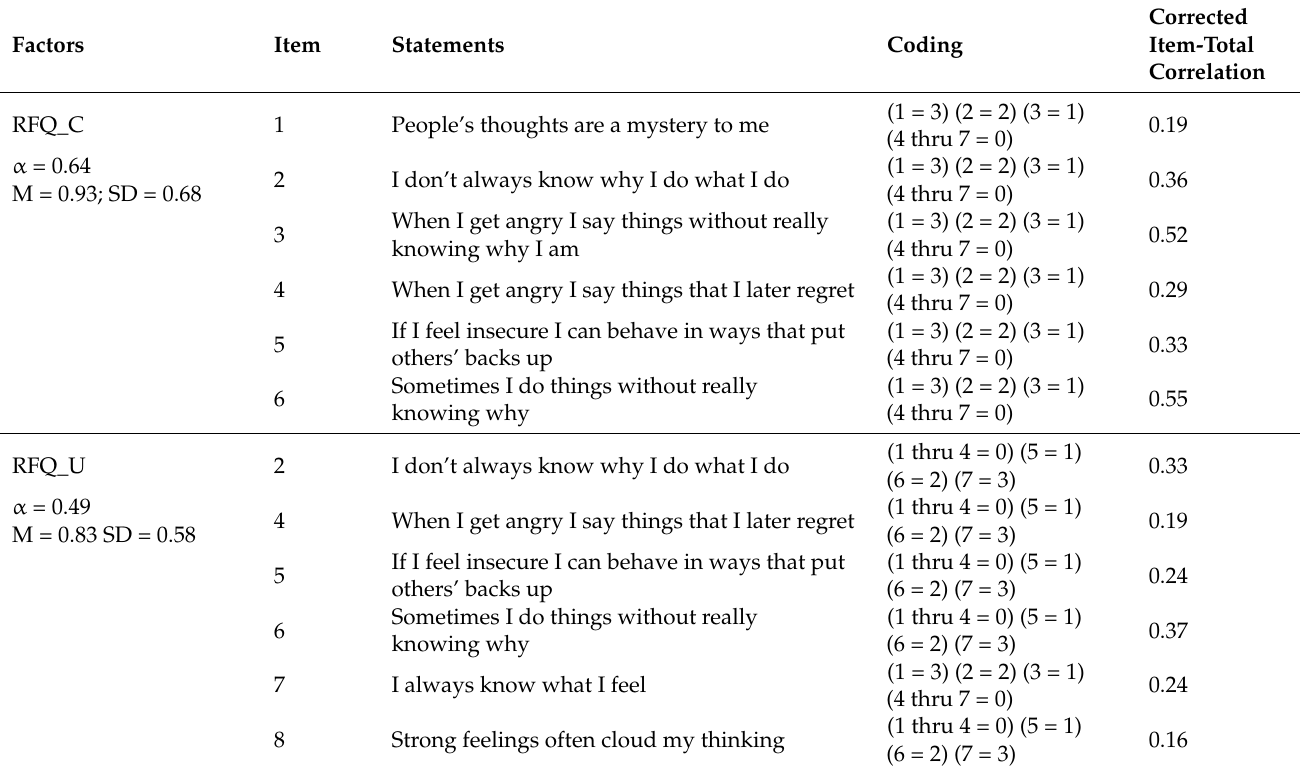
Table 1. Reliability of Reflective Functioning Questionnaire (RFQ) 1 .